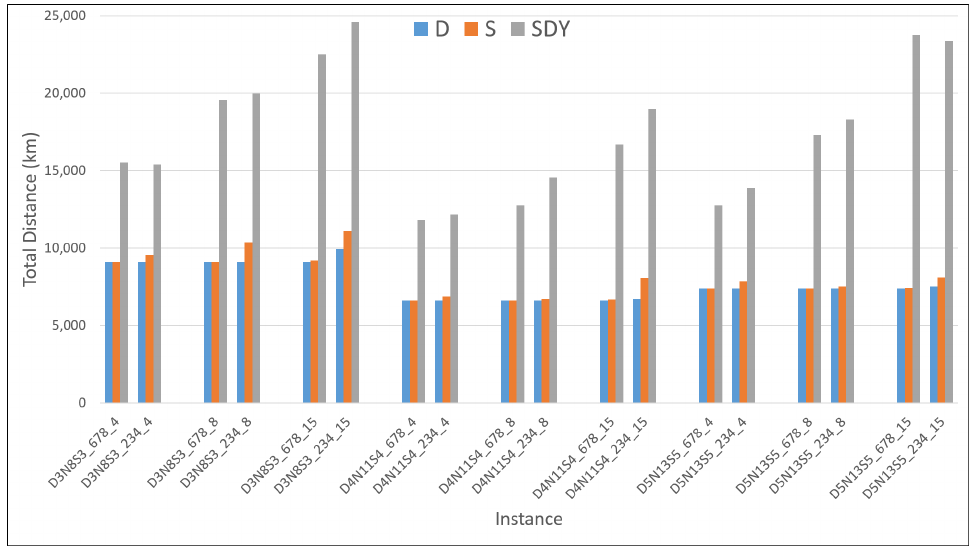
Figure A11. Total Distance Travelled: Offline and Online based on Model Characteristic and Maxi- mum Road Capacity Setting.